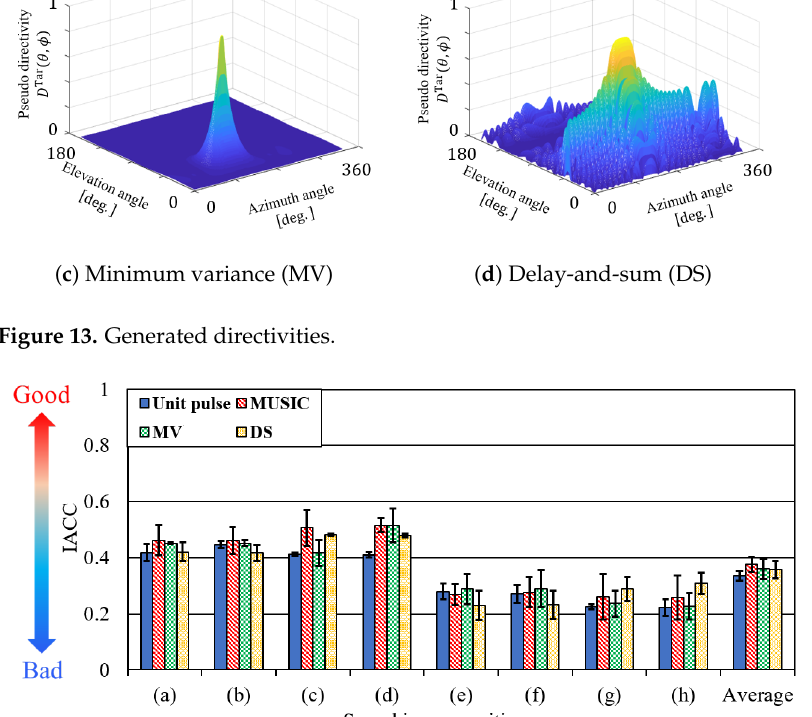
Figure 14. Inter-aural cross correlation (IACC) for each generated